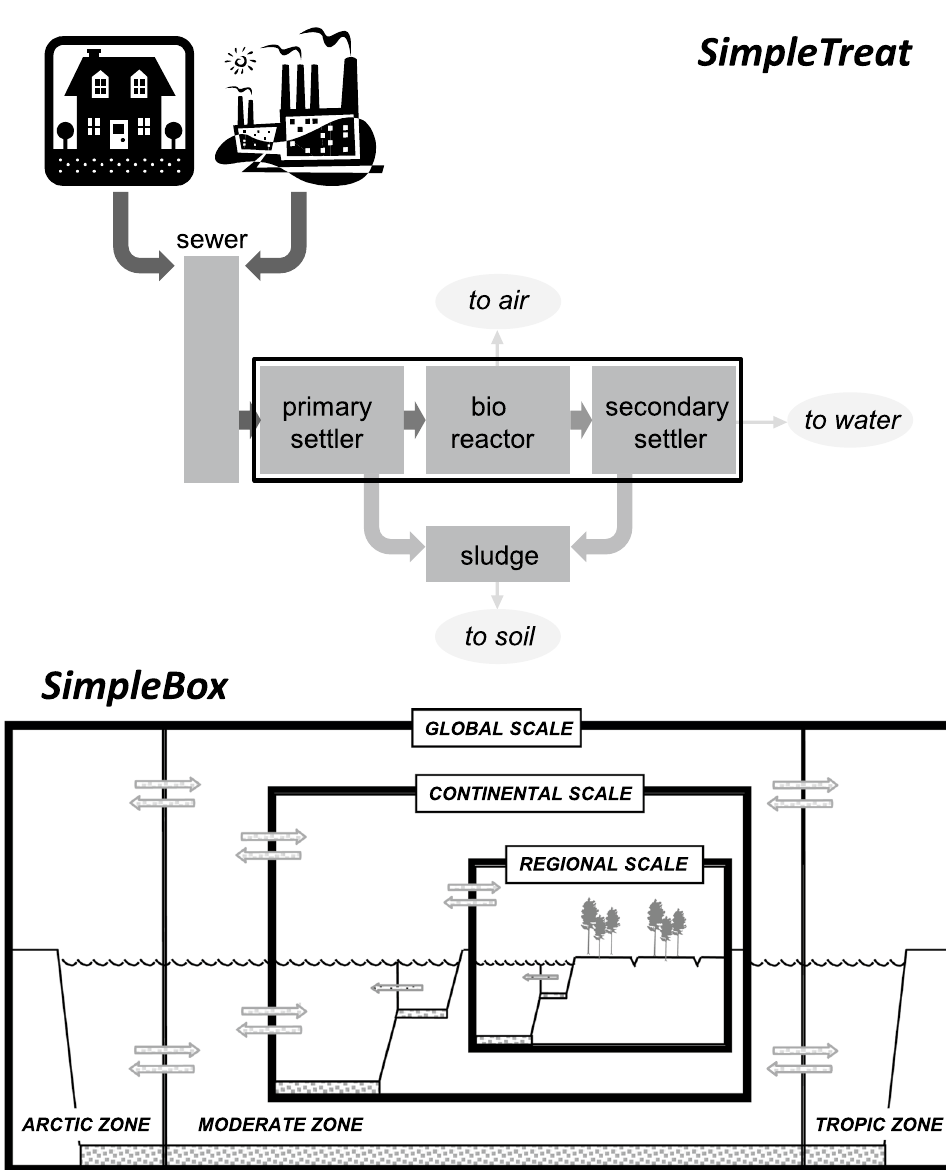
Fig. 2 Principle of exposure modeling in SimpleRisk. The multimedia mass balance model SimpleBox [17], combined with the sewage treatment plant simulation model SimpleTreat [18, 19], is used to estimate expected exposure concentrations of chemical substances, describing, explaining and predicting how and why different chemicals behave differently in the environment, depending on their physical and chemical substance